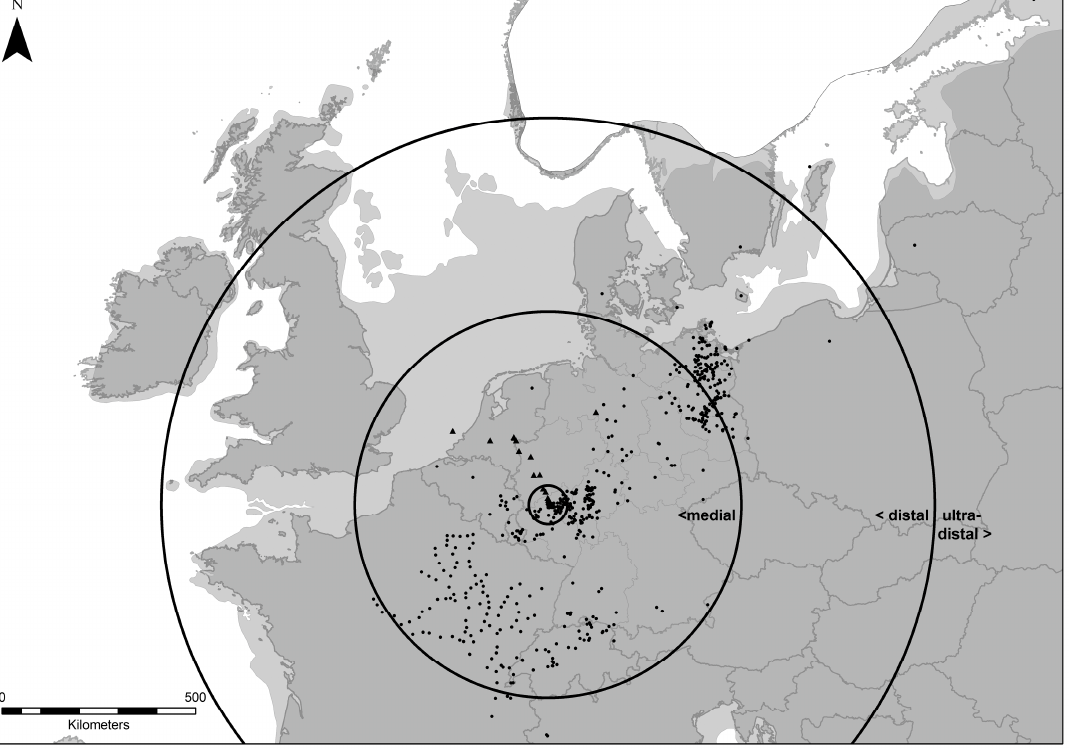
Figure 5. The spatial distribution of occurrences of Laacher See tephra across Europe. Table 2. Summary of key characteristics of the Laacher See eruption. BP = before present (1950); cal BP = calibrated years before present, i.e., the measured radiocarbon age has been converted (calibrated) to calendar age.